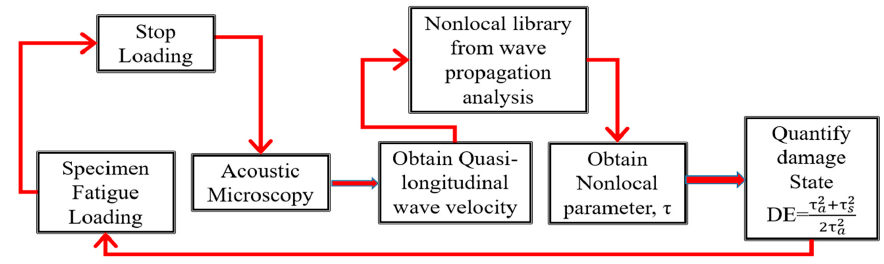
Figure 4. Process flow diagram showing the steps for damage quantification using nonlocal physics.